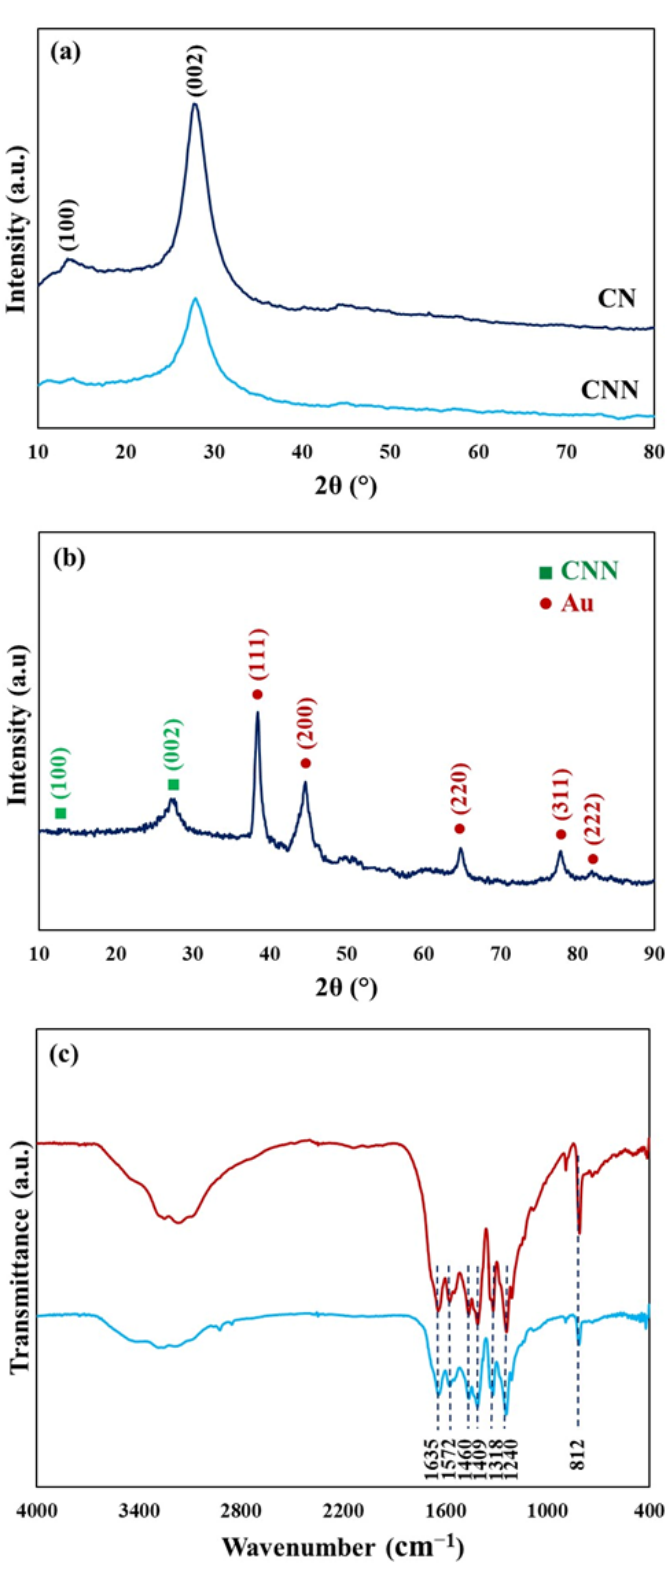
Figure 3. XRD patterns for ( a ) CN and CNN, ( b ) CNN/Au nanocomposite, and ( c ) FTIR spectra of CNN and CNN/Au nanocomposite.